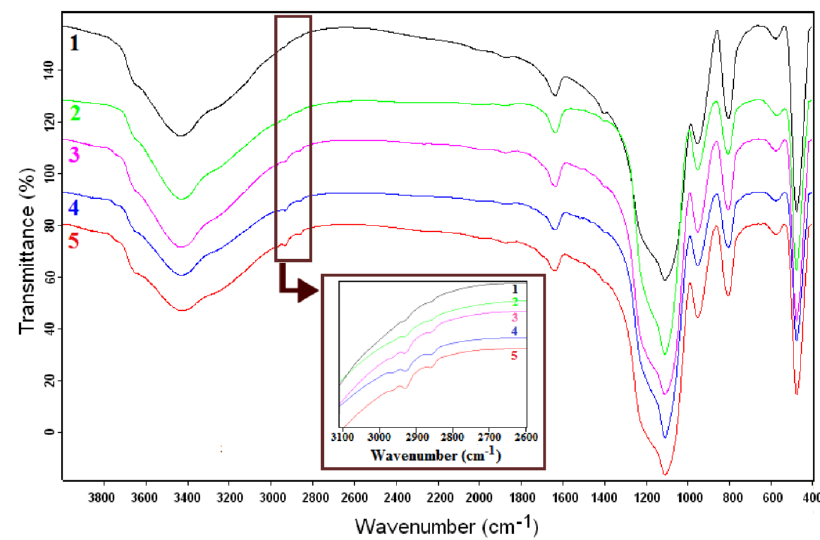
Figure 2. Fourier transform infrared (FTIR) spectra of dried SiO 2 NPs. Table 1. Thermal degradation of dried SiO 2 NPs.